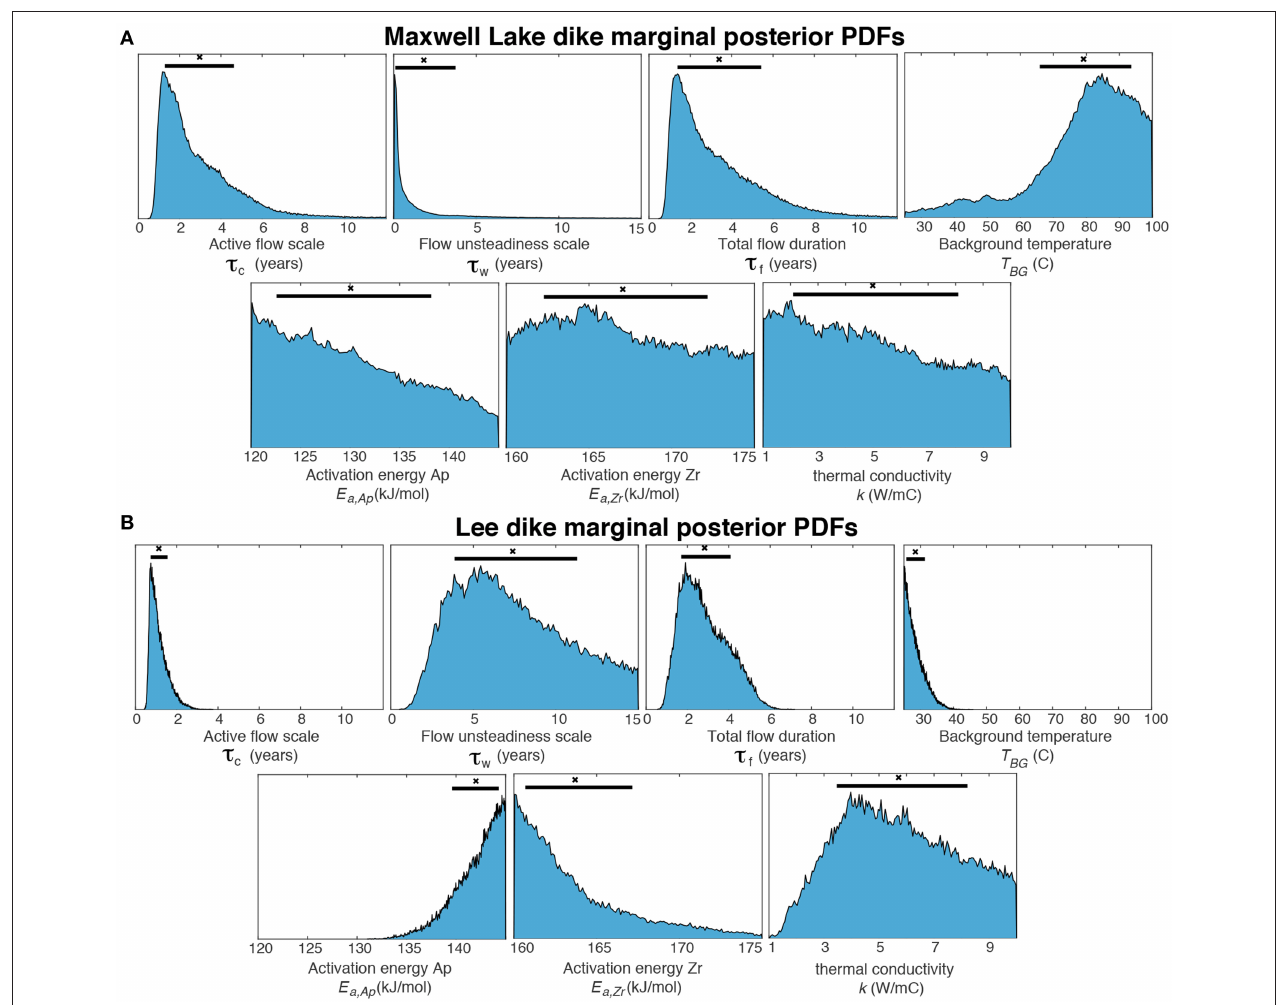
FIGURE 8 | Marginal posterior PDFs for (A) Maxwell Lake and (B) Lee dike parameters estimated from MCMC inversion ( τ f is derived using Equation 11). Black horizontal bars correspond to 68 % confidence intervals associated with expectation values from the posterior PDF, while black symbols are the median of the distribution ( Table 1